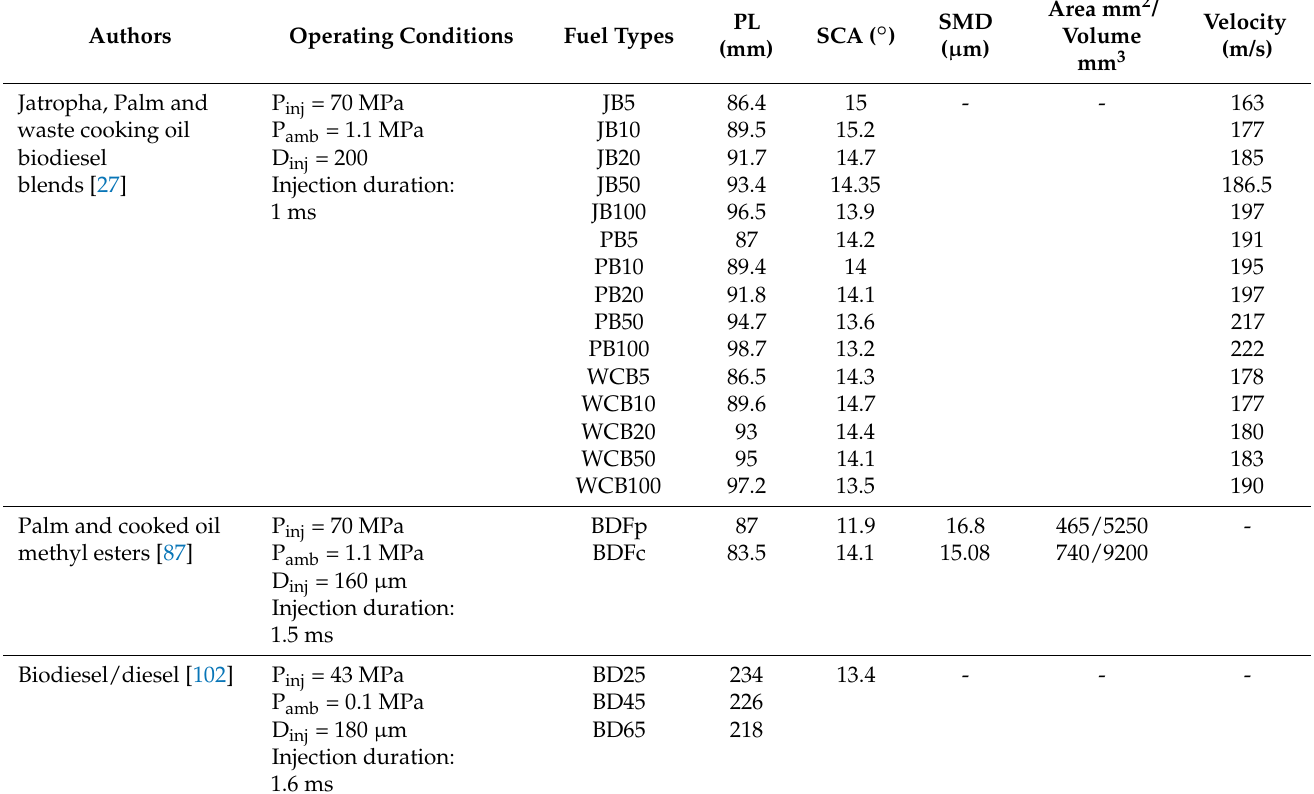
Table 6. Summary of spray properties of biodiesel and its blends with diesel